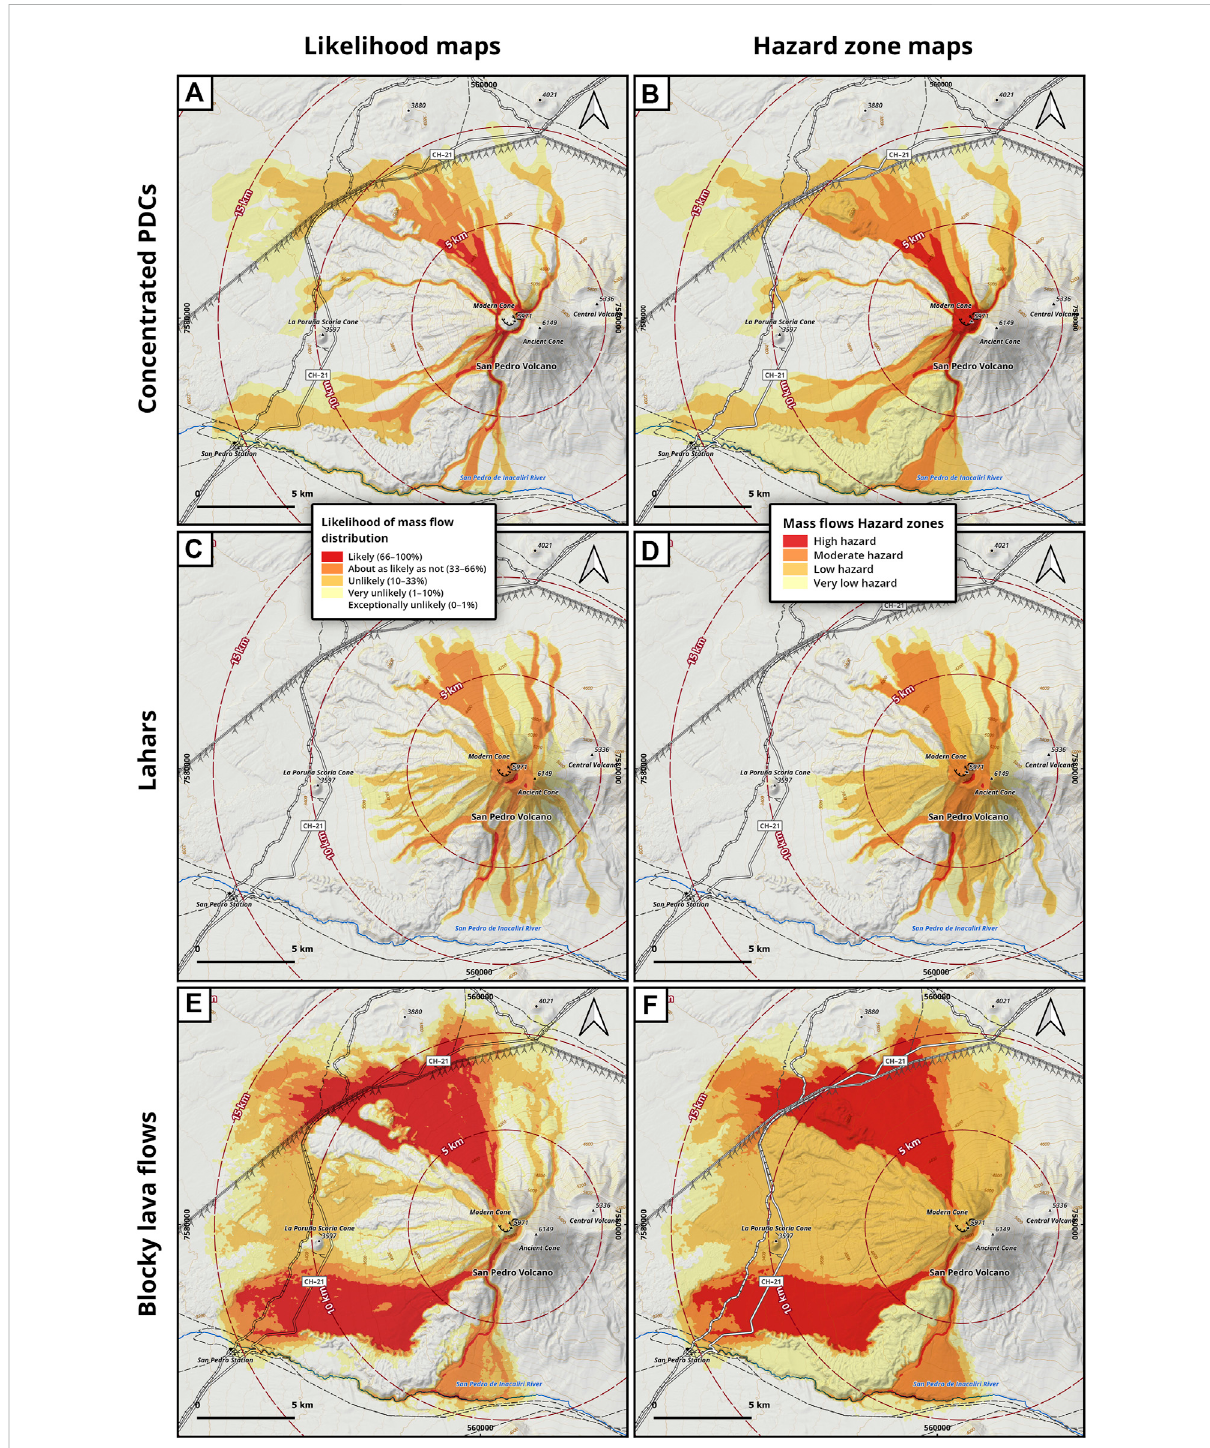
FIGURE 5 (A) likelihood map of concentrated PDCs. (B) hazard zone map of concentrated PDCs. (C) likelihood map of lahars. (D) hazard zone map of lahars. (E) likelihood map of blocky lava fl ows. (F) hazard zone map of blocky lava fl ows. (all maps in 1:100,000